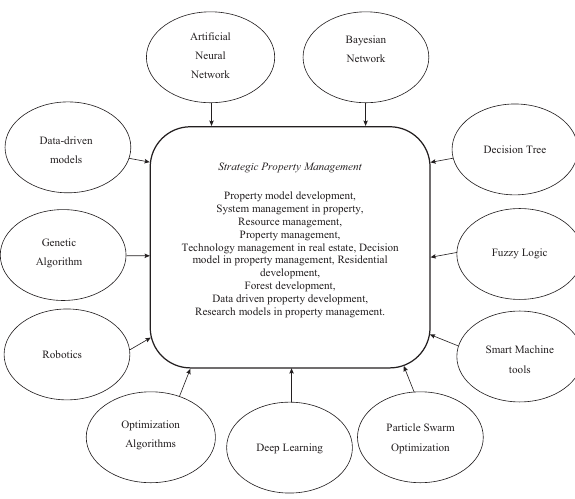
Figure 9. A proposed research framework for AI and